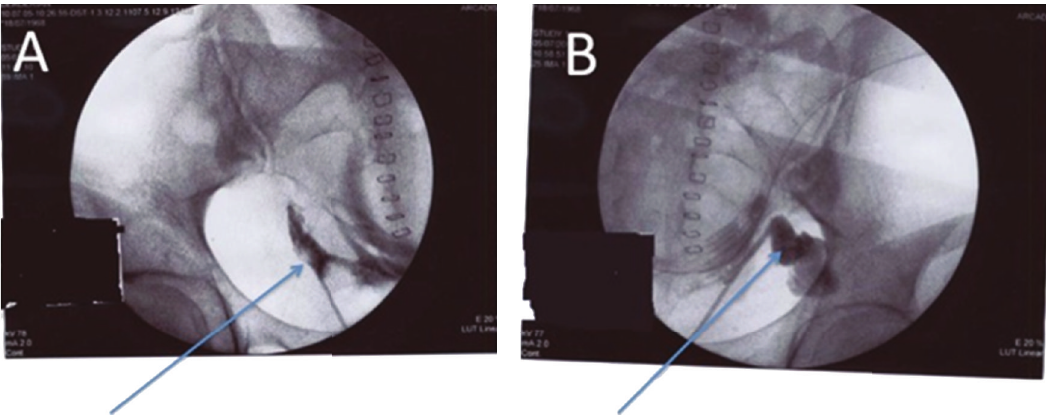
Figure 3: Retrograde ureteropyelography on postoperative day 17 showing extravasation of contrast agent from both pelvic ureters ((A) right, (B)